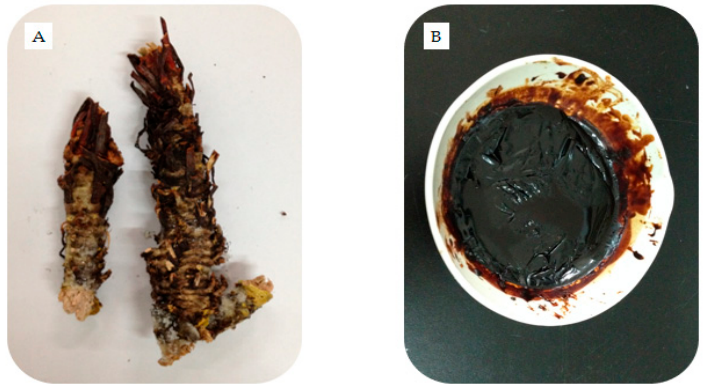
Figure 1. The rhizomes ( A ) and the ethanol extract ( B ) prepared from R. crenulata.